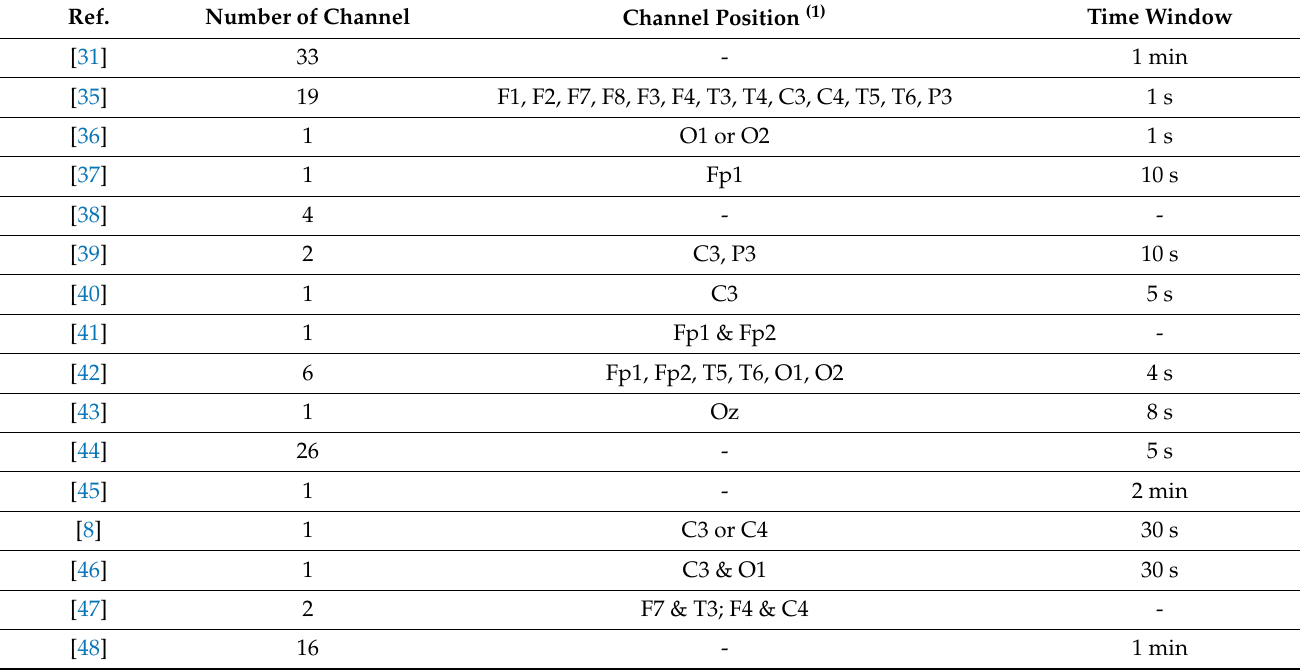
Table 1. Fifty-four Studies on EEG-based DDD listed with montages, as well as time windows for feature extraction, if